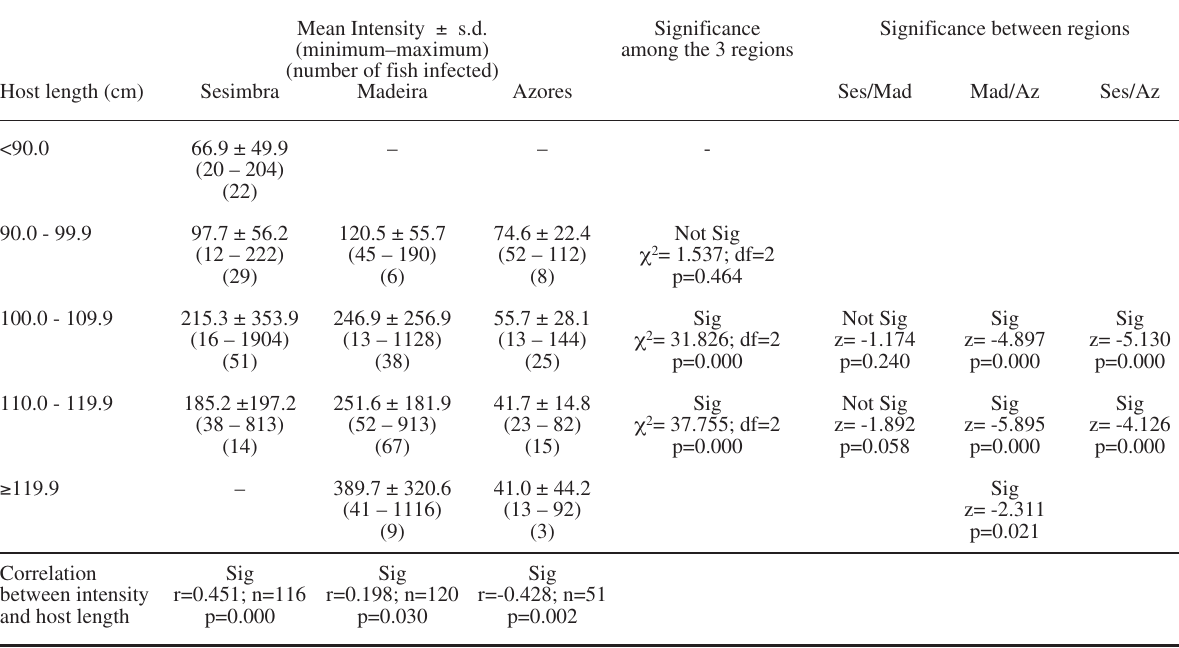
Table 3. – intensity of Anisakis larvae infection in Aphanopus carbo according to the host length: correlation between intensity and host length estimated by the spearman coefficient (r; n; p) and significance of intensity differences among regions in each length class estimated by the kruskal-Wallis ( c 2 ; df; p) or Mann-Whitney (z; p) test (sig, significantly different or correlated). Mean intensity ± s.d. significance significance between regions (minimum–maximum) among the 3 regions (number of fish infected)